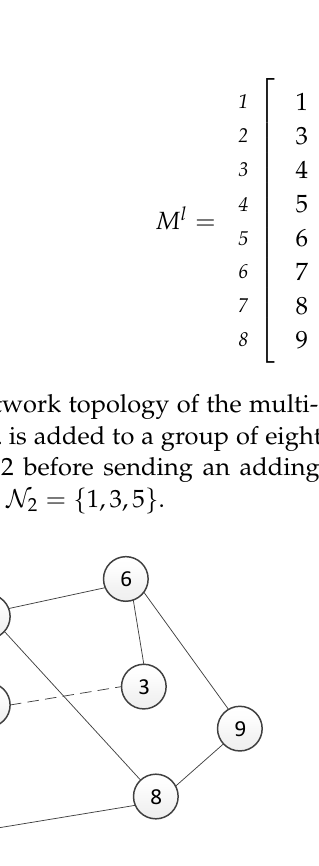
Figure 4. Network topology of the multi-agent system when a new agent is added. Solid lines represent a graph topology of 8 agents, while dashed lines represent established links of a new agent whose identification address is